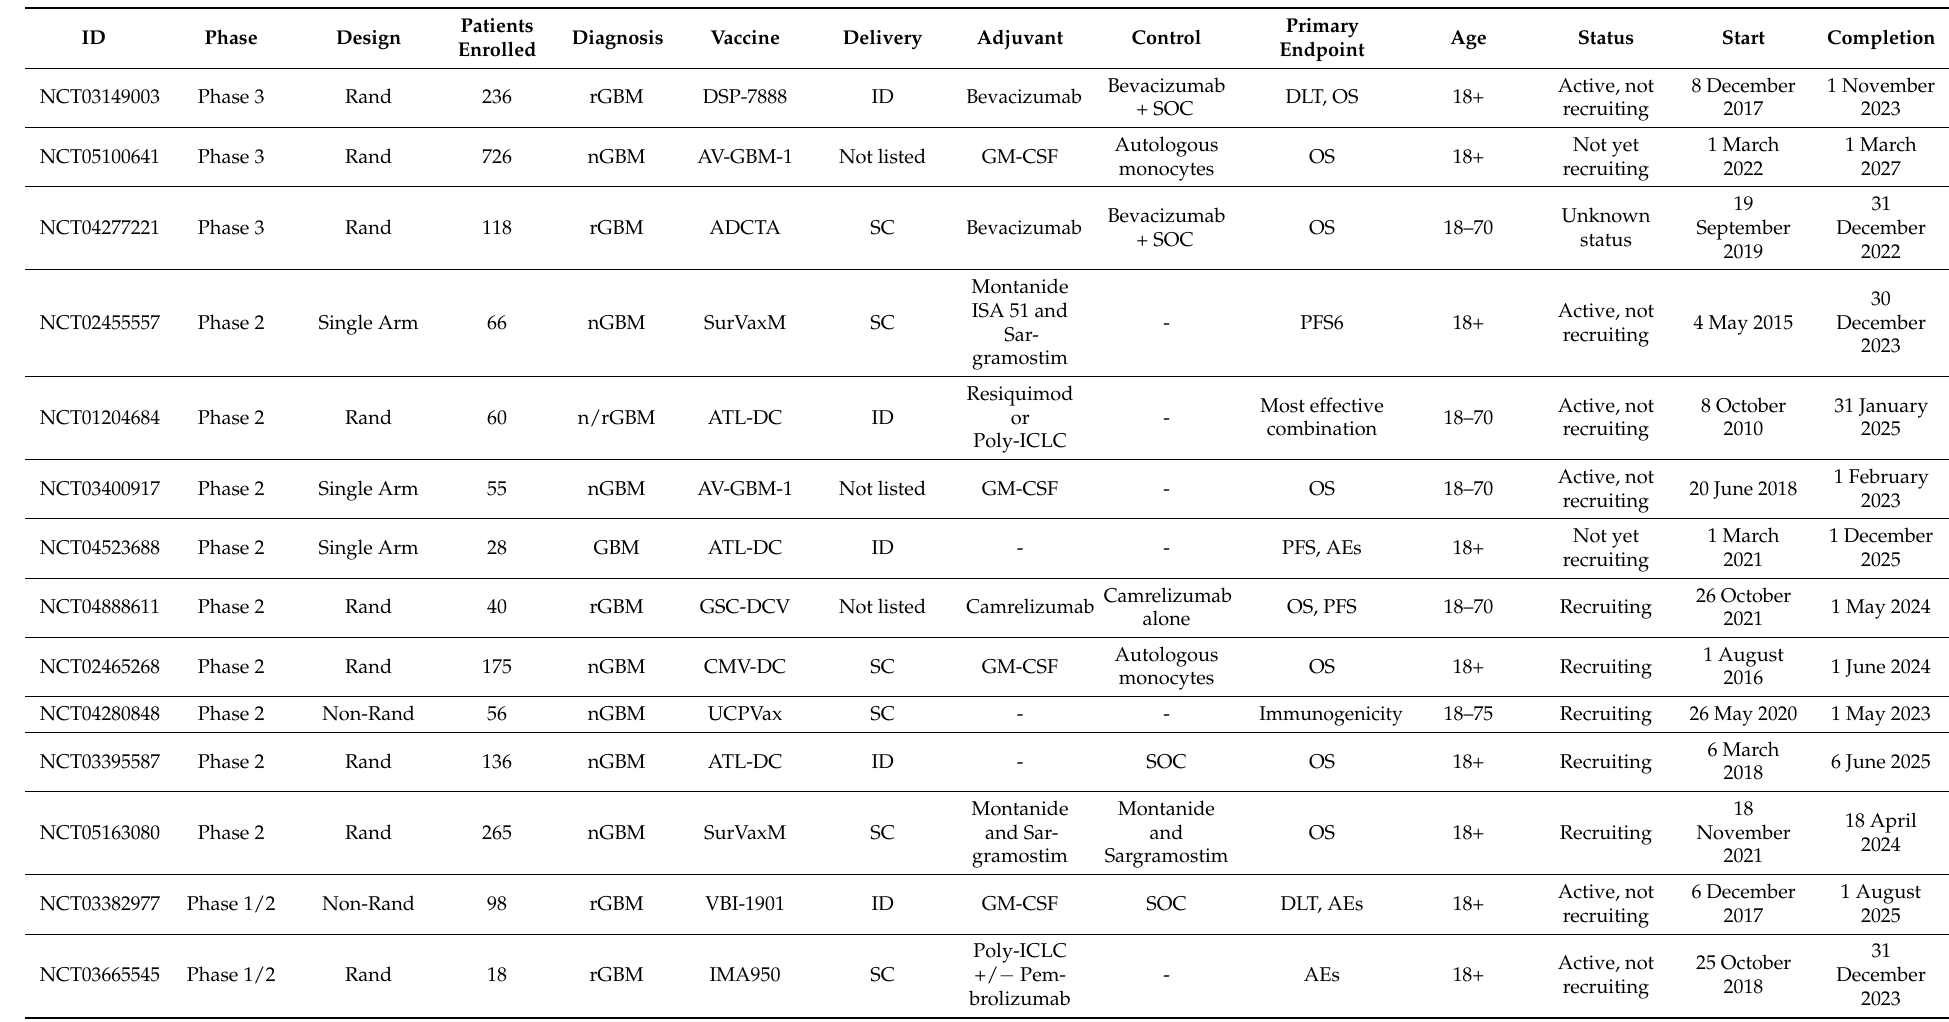
Table 1. Active, recruiting, or soon-to-be-recruiting clinical trials investigating therapeutic vaccinations for